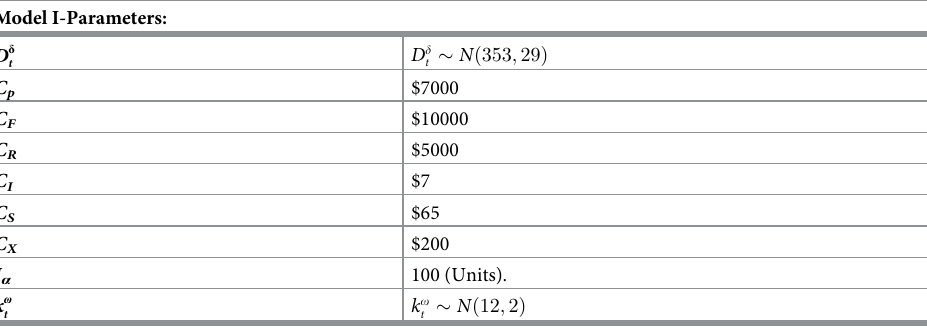
Table 3. Parameters in Model I. Own elaboration based in the organization information. Model